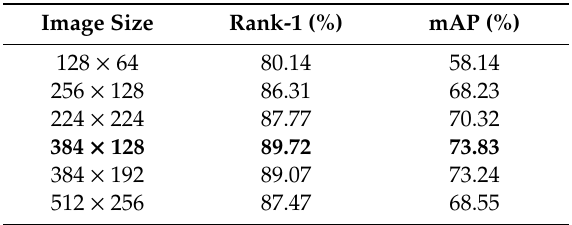
Table 4. Comparison of the di ff erent proportion of global loss.